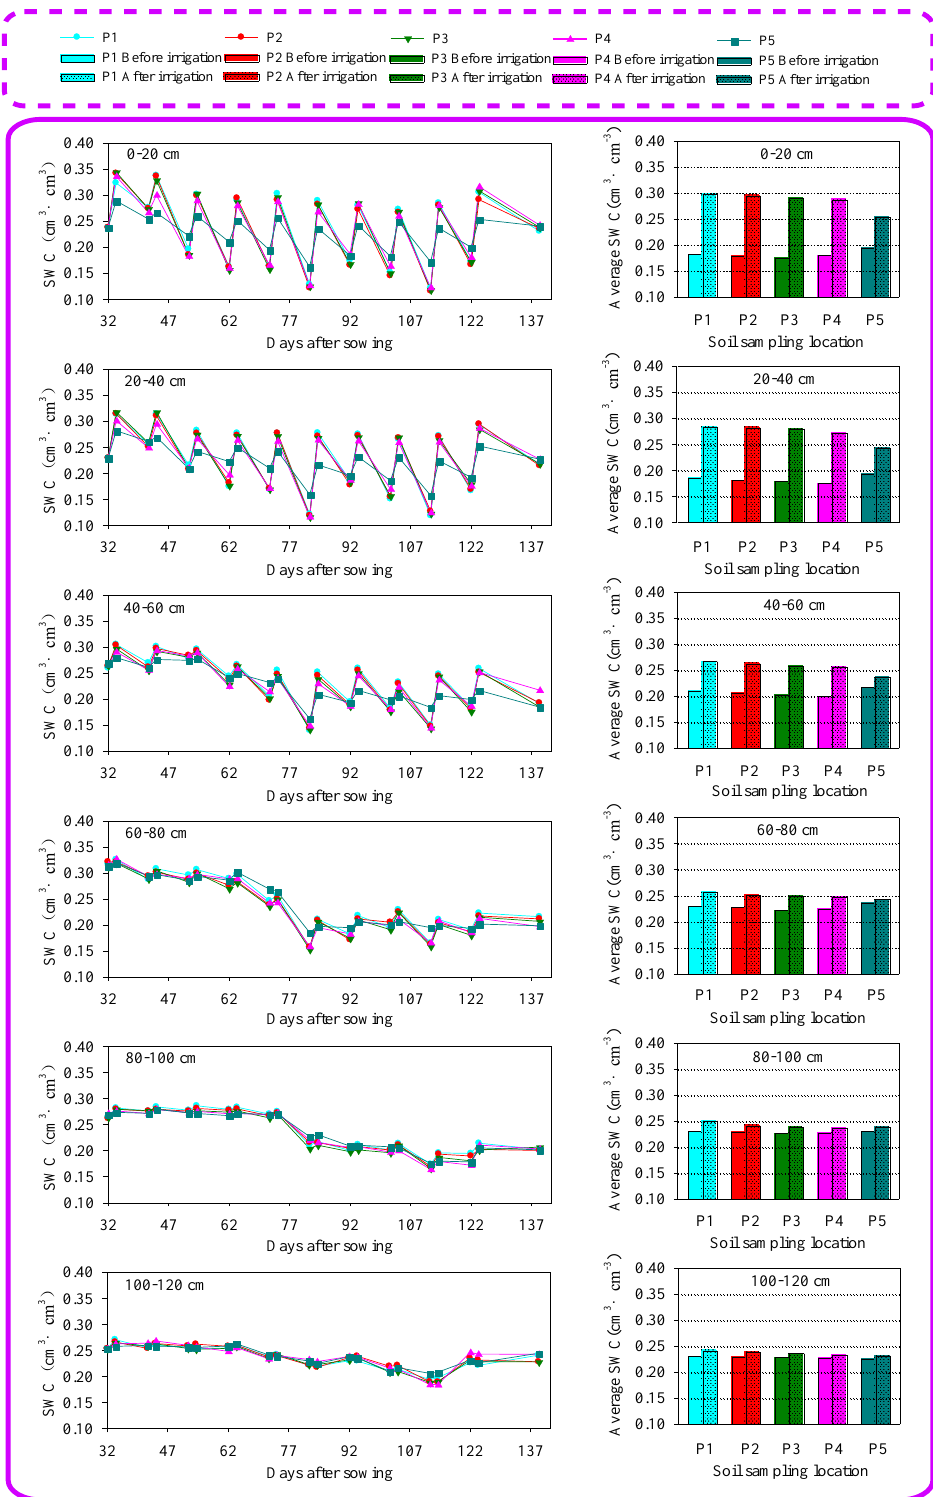
Figure 5. SWC in the 0–120 cm soil layers at full growth stage of spring maize in different irrigation and fertigation treatments in 2016.